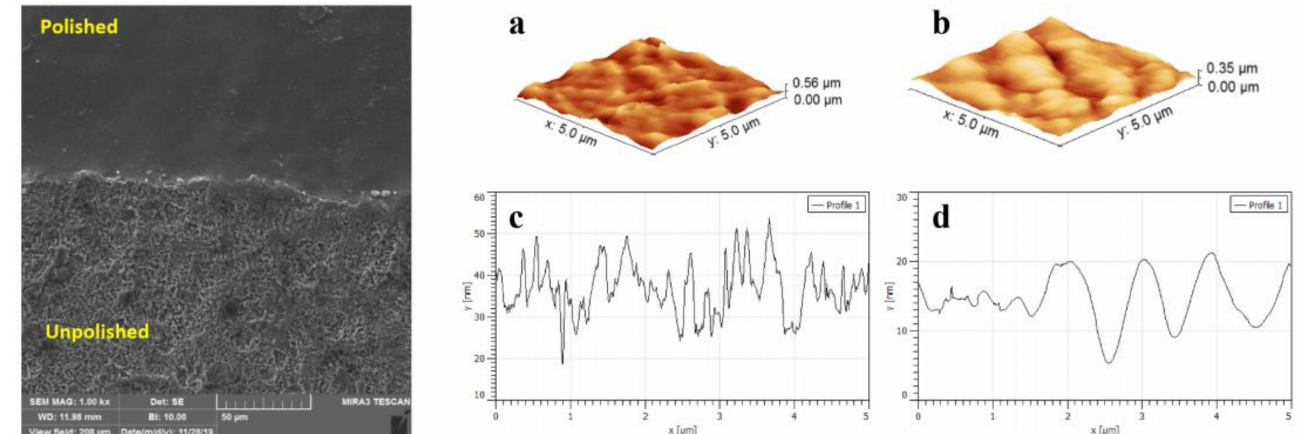
Figure 4. SEM (left) and AFM (right) images of Ti samples before electropolishing ( a , c ) and after electropolishing ( b , d ) (reprinted with permission from ref. [42]; Copyright 2020 by the author(s), published by the Electrochemical Society of